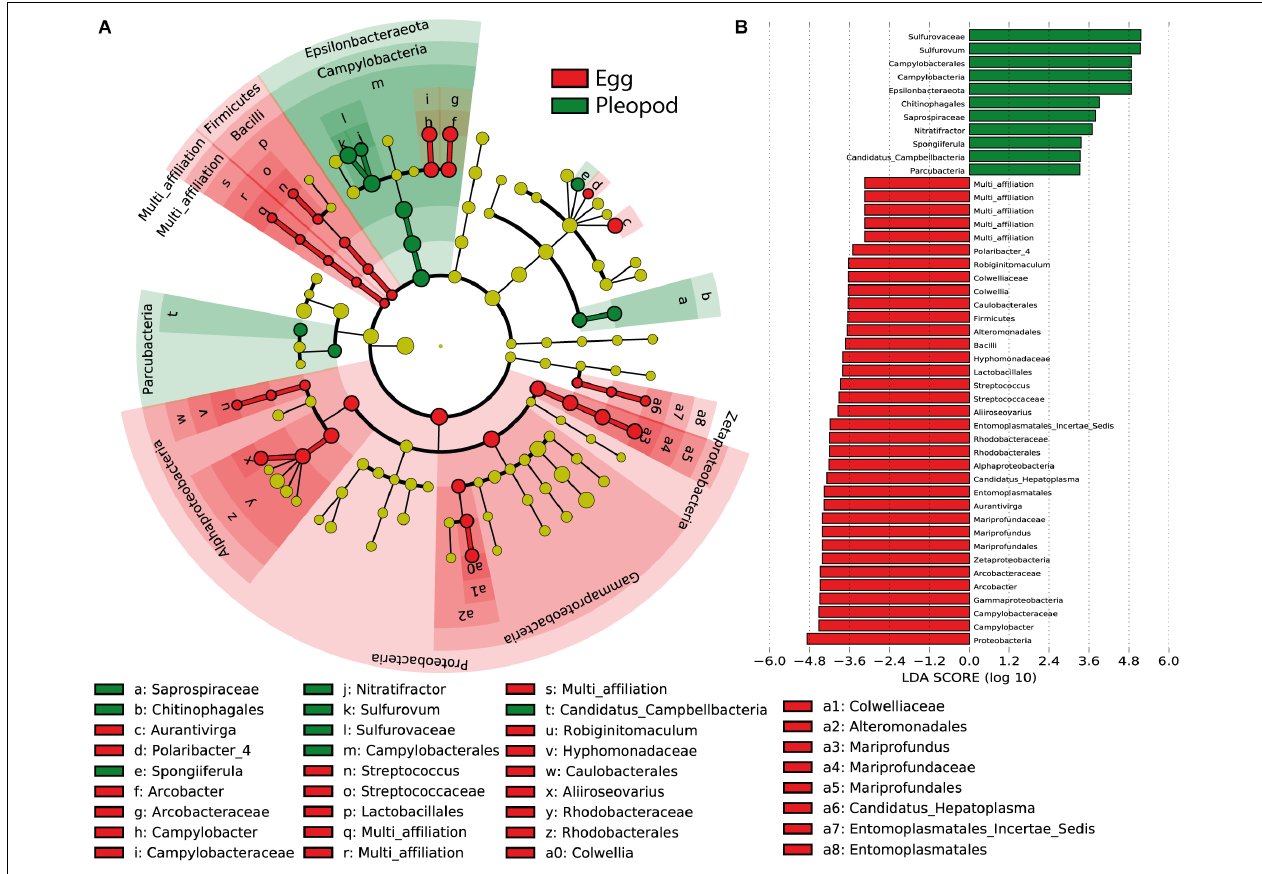
FIGURE 4 | Most differentially abundant bacterial taxa between eggs (red) and pleopods (green). (A) Cladogram representing taxonomic distribution of the differentially abundant bacterial taxa. The dots represent the specific bacterial taxa, with colors corresponding to the surface (eggs or pleopods) where these are relatively more abundant, yellow-greenish color denoting taxa with no significant difference in relative abundance between eggs and pleopods. The size of dots is proportional to the relative abundance. (B) Ranked LDA scores of the differentially abundant bacterial taxa, with taxa with highest relative abundance in pleopods in green, and taxa with highest relative abundance in eggs in